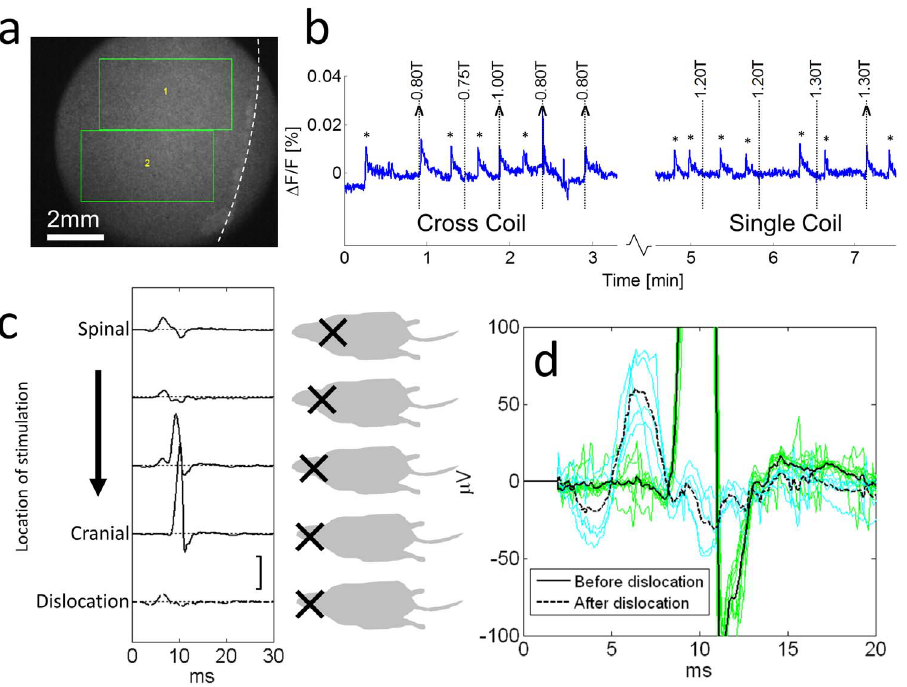
Figure 5. Results from neuronal culture and from rat motor cortex. a) The response of 2D Neuronal culture to rfTMS. Spiking activity in the culture was imaged through the viewing aperture (see Figure 2b). Fluorescent neurons are seen as white spots. The green rectangles indicate the regions of interest over which the signal was averaged. The dashed white line indicates the borders of the coverslip on which the culture was grown. b) The average calcium dependent fluorescence of the regions of interest outlined in a). Dashed lines mark events of magnetic stimulation using first the cross coil and then a single coil. The intensity of each stimulation pulse is noted in Tesla. Successful stimulation of a population response is indicated by a caret while intrinsic activity unrelated to magnetic stimulation is indicated by an asterisk. Note that the cross coil successfully triggered a response already with 0.8T (but not at 0.75T), while a single coil required around 1.3T. c) The response of rat motor cortex to rfTMS. Graphs of EMG recording of the Gastrocnemius when using the cross coil to stimulate a rat at different locations. Each location is illustrated to the right of the response trace with the black cross representing the cross coil. The last row was performed after cervical dislocation of the rat. Scale bar is 200 m V . d) A comparison between the last two rows in c). The solid line is the average of 10 individual responses (green traces) of the rat to rfTMS over its head before dislocation and the dashed curve is the average of 5 individual responses (cyan traces) of the rat to rfTMS in a similar location over its head after